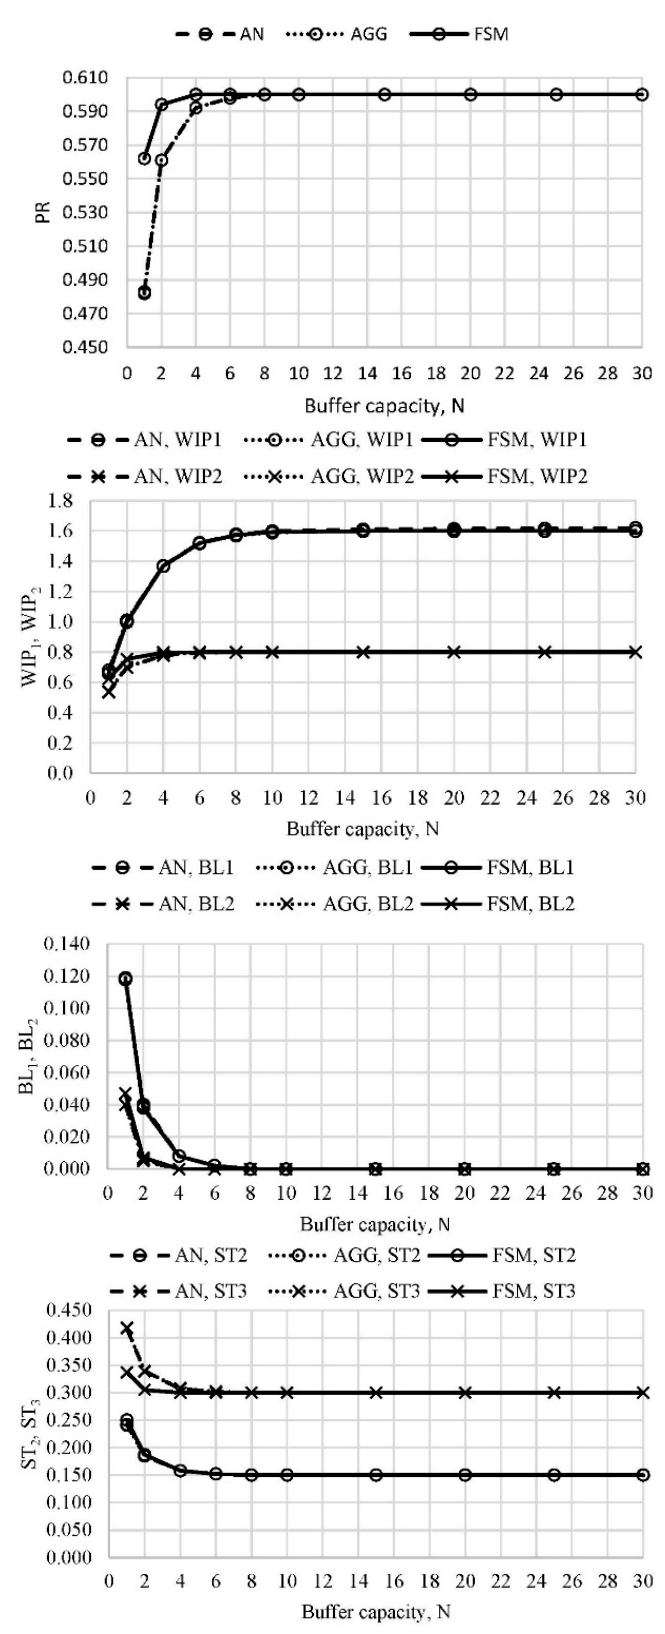
Figure 6. PR , WIP 1 , WIP 2 , BL 1 , BL 2 , ST 2 , and ST 3 in case of the line L 2 , N 1 = N 2 = N (authors’ work).